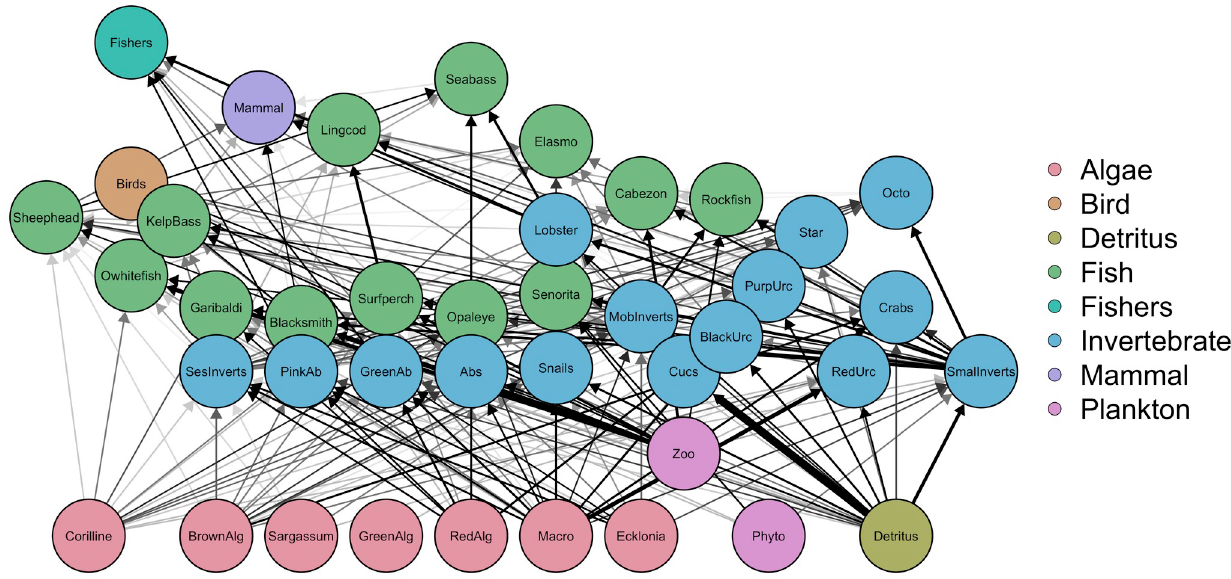
Fig 2. Food web network diagram of the Isla Natividad model. Lines represent diet interactions and the strength of each interaction is represented by the line color and thickness (dark > light, thick > thin). Major ecosystem groups are represented by different colors.